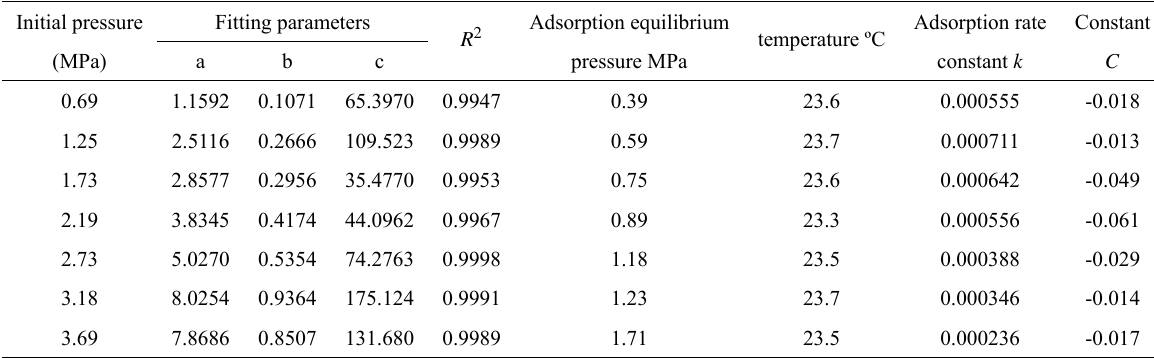
Adsorption rate constants for coal with 2.891% moisture content.